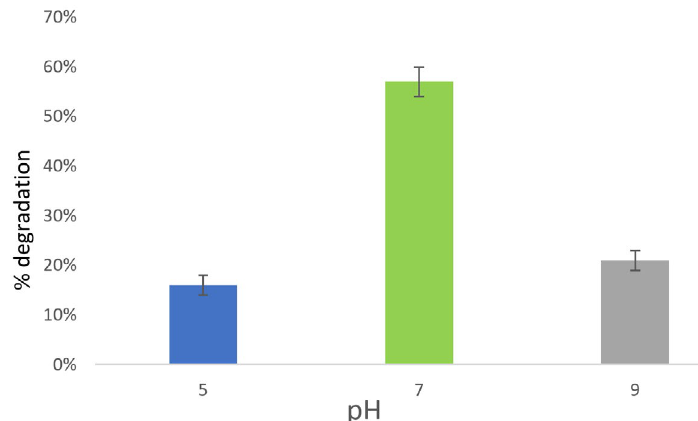
Fig. 5. Feather degradation by Bacillus pumilus at different pH.